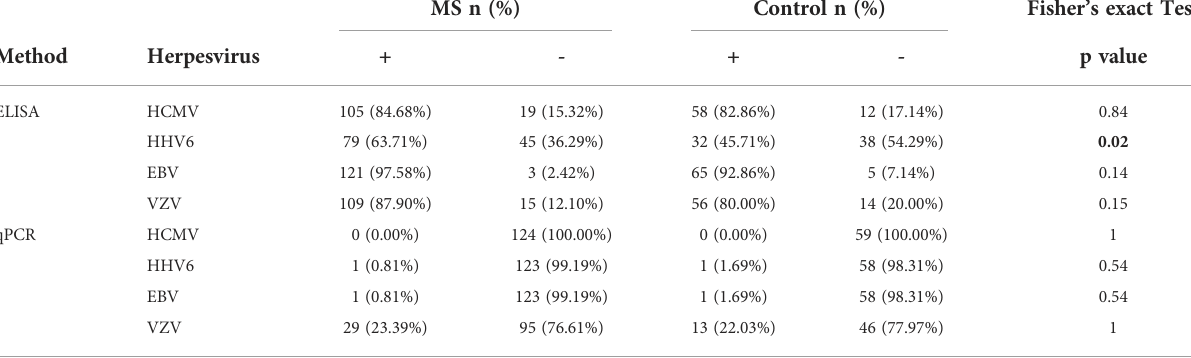
TABLE 2 Analysis of anti-herpesvirus antibody and DNA in MS and